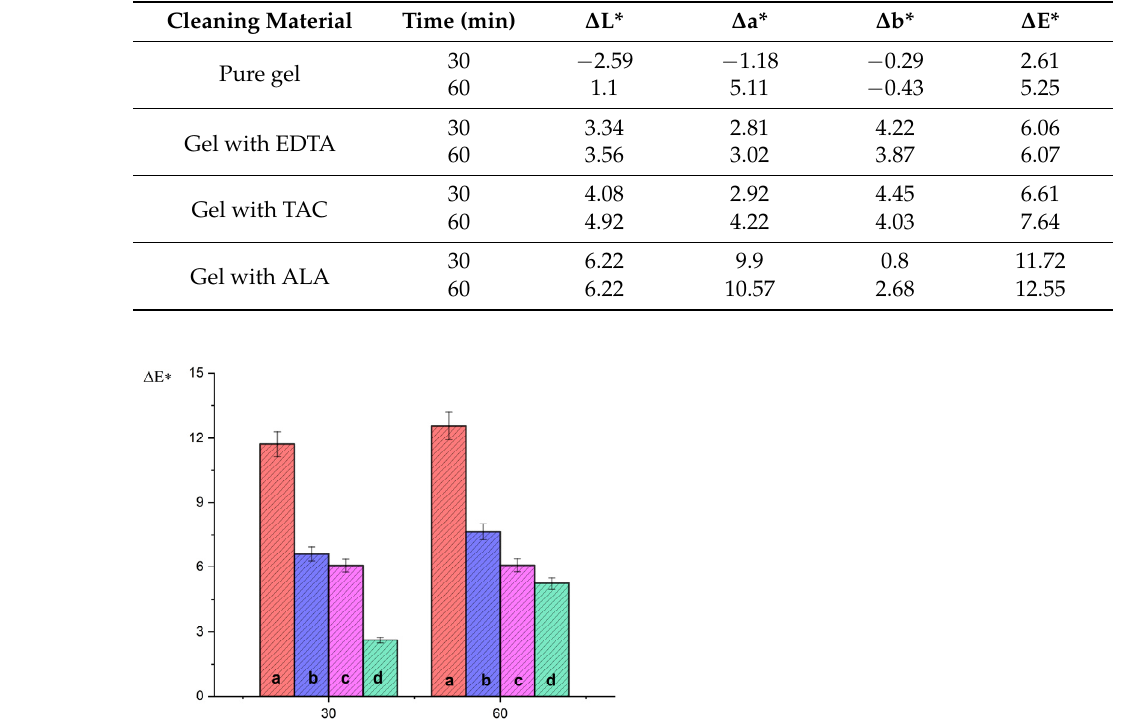
Table 3. Global color variations ( ∆ L*, ∆ a*, ∆ b*, ∆ E*) before (t 1 ) and after (t 2 ) cleaning of stained laboratory specimens after 30 and 60 min contact.